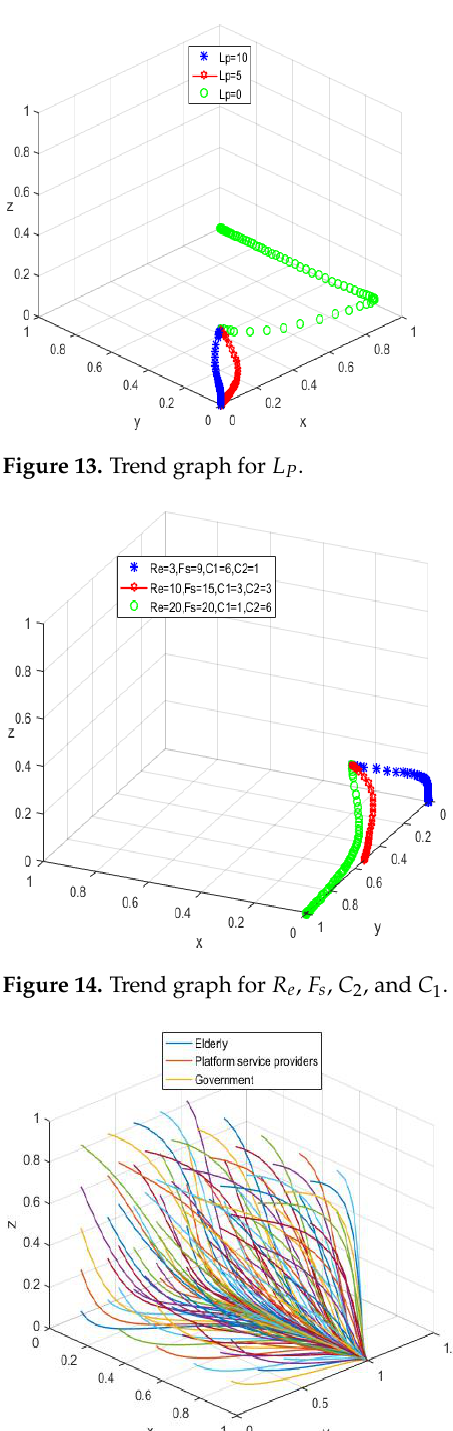
Figure 15. Optimized equilibrium state.